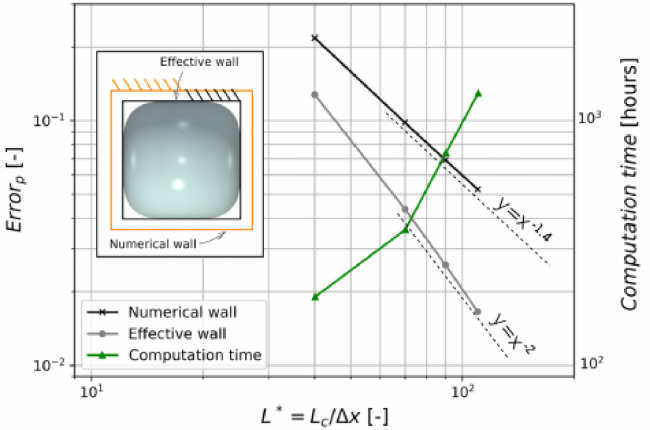
Convergence of the LBM result with mesh refinement, with regard to error defined in Eq. (15). Each simulation is ran in parallel using 8 cores. Lcis defined as the distance between the numerical walls (unchanged by wall retraction).